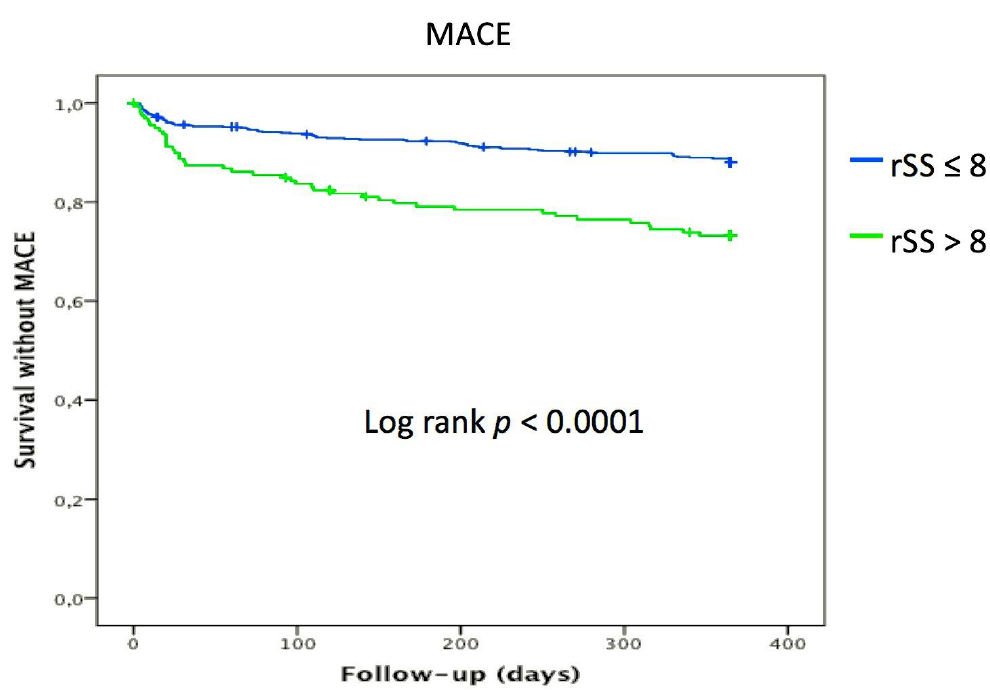
Figure 4. Kaplan Meier analysis for the probability of MACE event-free survival according to rSS. Table 5. Outcomes at one year follow-up according to